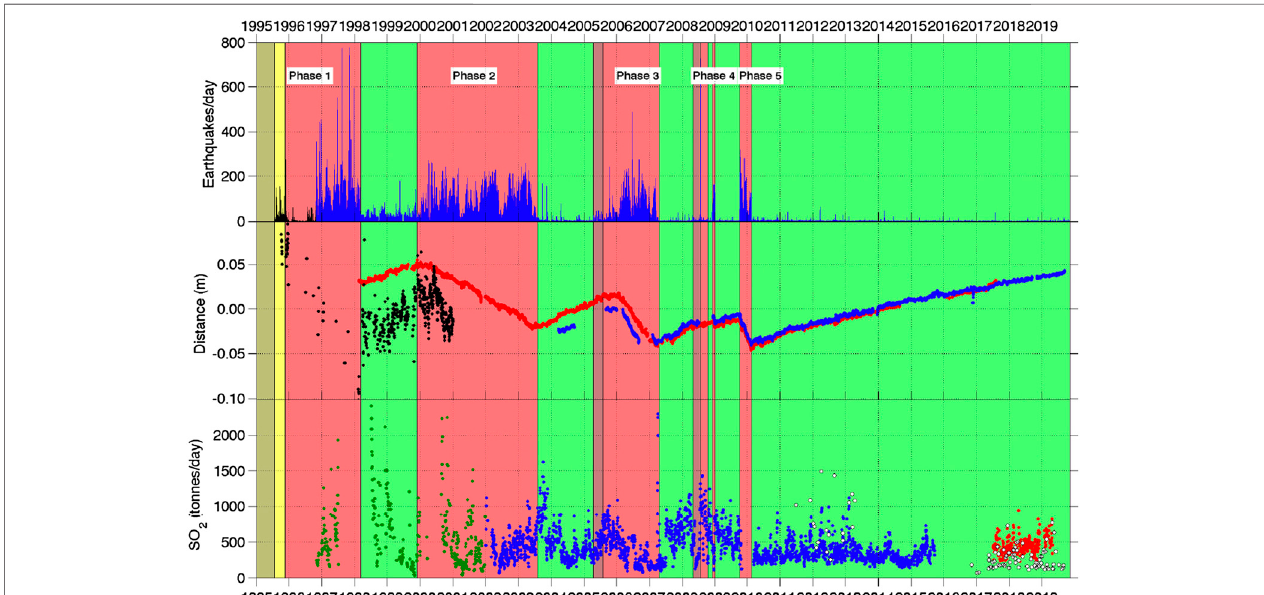
FIGURE1| Seismic, Global Positioning System (GPS), and SO 2 monitoring data for the period January 1, 1995 – November 7, 2019. Extrusive phases and pauses are in shown red and green, respectively. Top: Number of seismic events detected by the seismic system. Middle: Radial ground displacement of continuous GPS (cGPS) stations MVO1 (red) and GERD (blue) smoothed with 7-days running mean fi lter, Black: GPS Height of HARR. Bottom: Measured daily SO 2 fl ux, fi ltered with 7-days running median fi lter. Green: Correlation Spectrometer (COSPEC), Blue: Differential Optical Absorption Spectroscopy (DOAS), White: Traverse data, Red: new DOAS network (Adapted from MVO activity report; MVO OFR 18-02-draft).